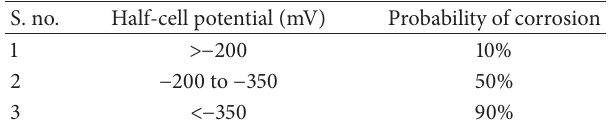
Table 2: Presents criteria according to ASTM C876 for Cu/CuSO